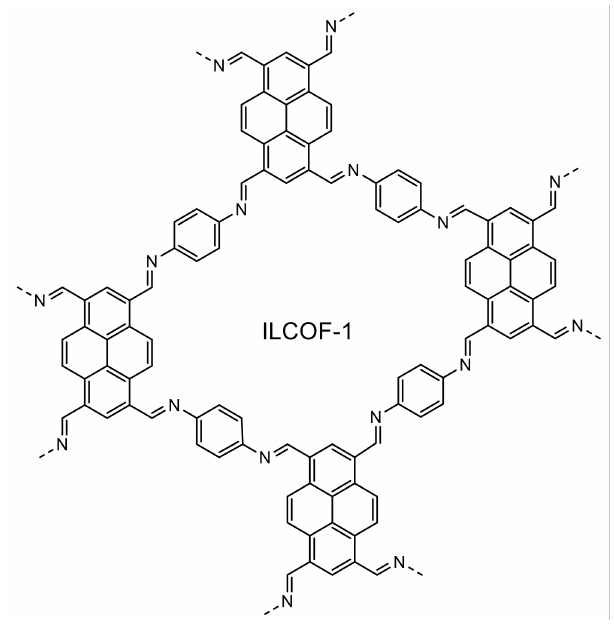
Figure 4. Structure of